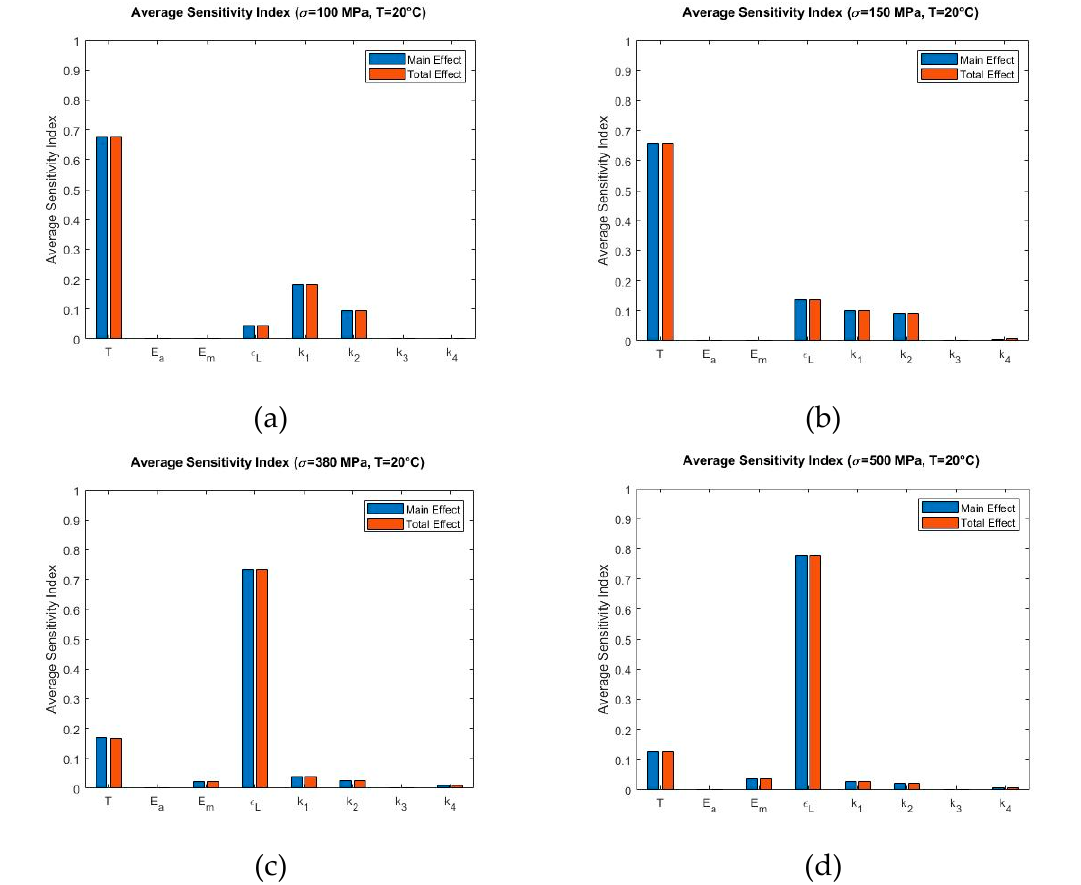
Figure 9. Sobol average sensitivity indices at simulated temperatures and maximum loading: ( a ) T = 20 ◦ C, σ max = 100 MPa ( b ) T = 20 ◦ C, σ max = 150 MPa ( c ) T = 20 ◦ C, σ max = 380 MPa ( d ) T = 20 ◦ C, σ max = 500 MPa.